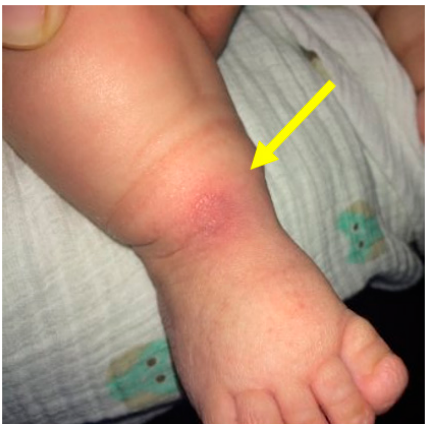
Figure 12. Clinical picture showing an anterior ankle pressure area (pointed by the arrow) caused by a brace tightened excessively.